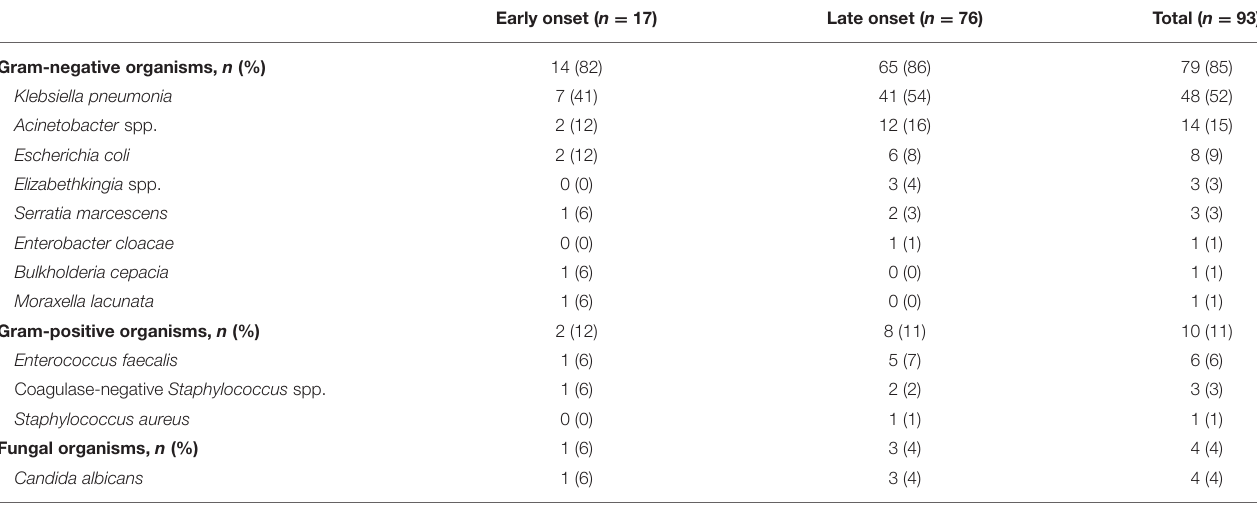
TABLE 3 | Distribution of pathogens in early onset and late onset culture-positive infections.